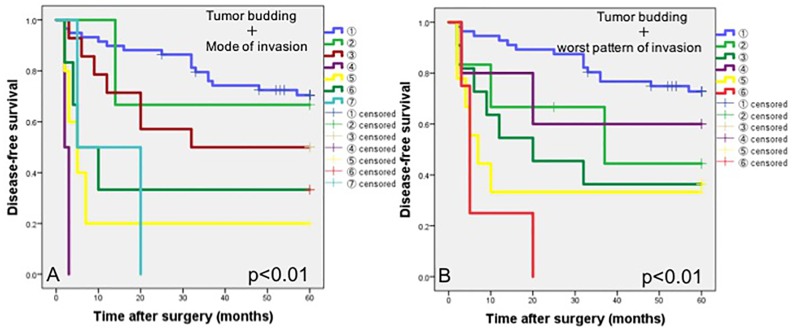
Kaplan-Meier curves of disease-free survival (DFS) in patients in combined groups with the intensity of tumor budding and mode of invasion (A) or worst pattern of invasion (WPOI) (B).In group A, the 5-year DFSs were 70.4% with low tumor budding and grade 1+2+3 mode of invasion ①, 66.7% with low tumor budding and grade 4C mode of invasion ②, 50.0% with intermediate tumor budding and grade 1+2+3 mode of invasion ③, 0% with intermediate tumor budding and grade 4C mode of invasion ④, 20.0% with high tumor budding and grade 1+2+3 mode of invasion ⑤, 33.3% with high tumor budding and grade 4C mode of invasion ⑥, and 0% with high tumor budding and grade 4D mode of invasion ⑦. In group B, the 5-year DFSs were 72.8% with low tumor budding and WPOI-1+2+3+4 ①, 44.4% with low tumor budding and WPOI-5 ②, 36.4% with intermediate tumor budding and WPOI-1+2+3+4 ③, 60.0% with intermediate tumor budding and WPOI-5 ④, 33.3% with high tumor budding and WPOI-1+2+3+4 ⑤, and 0% for high tumor budding and WPOI-5 ⑥.